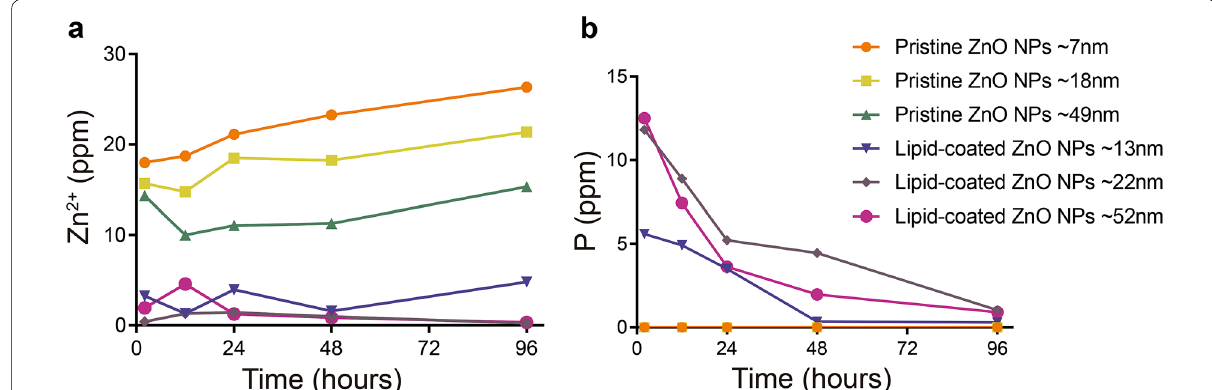
Fig. 8 The ICP-OES analysis of a zinc and b phosphorus elements present in water at different time points of the biostability assays from different